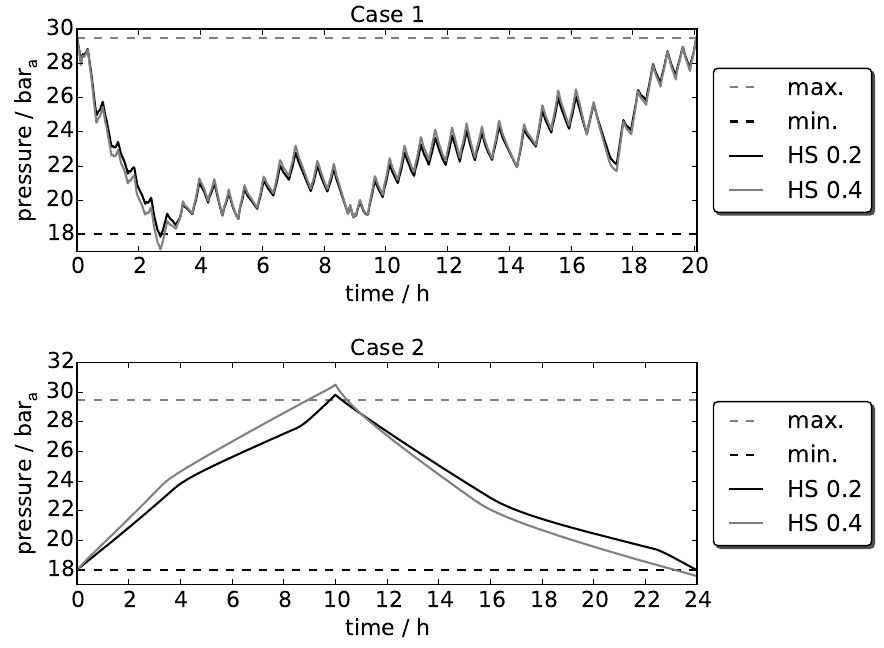
Figure 5. Pressure inside the storage vessels for Case 1 and Case